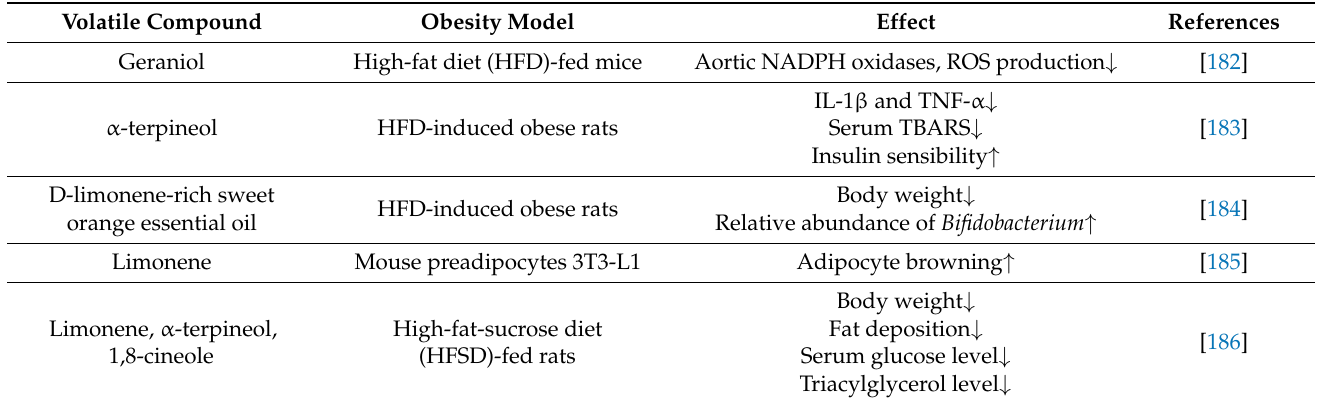
Table 4. The effect of volatile compounds rich in berries on obesity